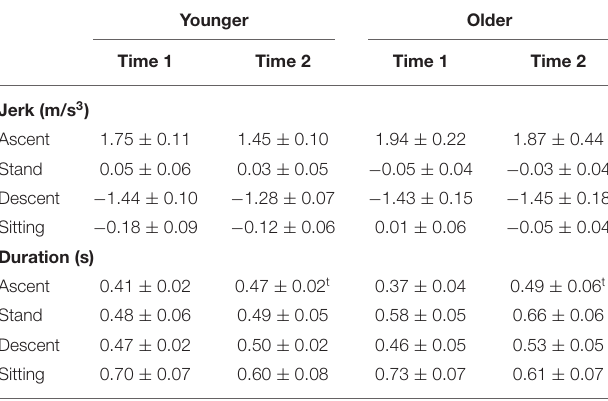
TABLE 3 | Jerk and duration of sit-to-stand (STS) phases (ascent, stand, descent, sitting for younger and older adults considering time 1 (initial-stage) and time 2 (late-stage) of repetitive STS.